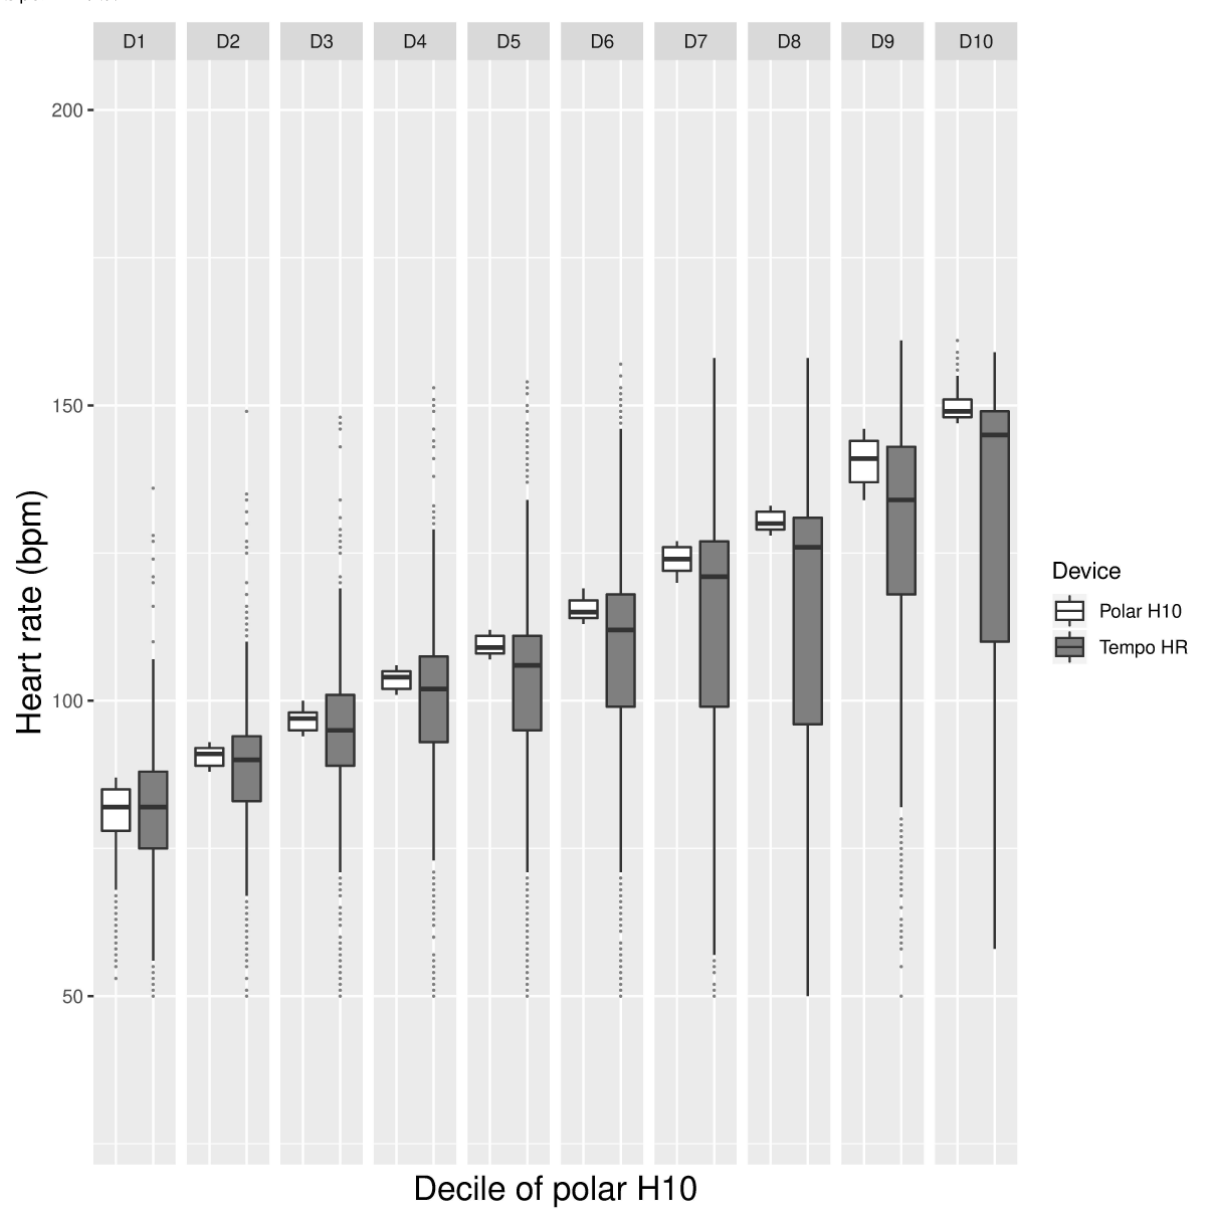
Figure 3. Laboratory phase: box plot providing by-decile comparisons of mean Polar H10 (white) and Tempo HR HR data (gray). HR: heart rate; bpm: beats per